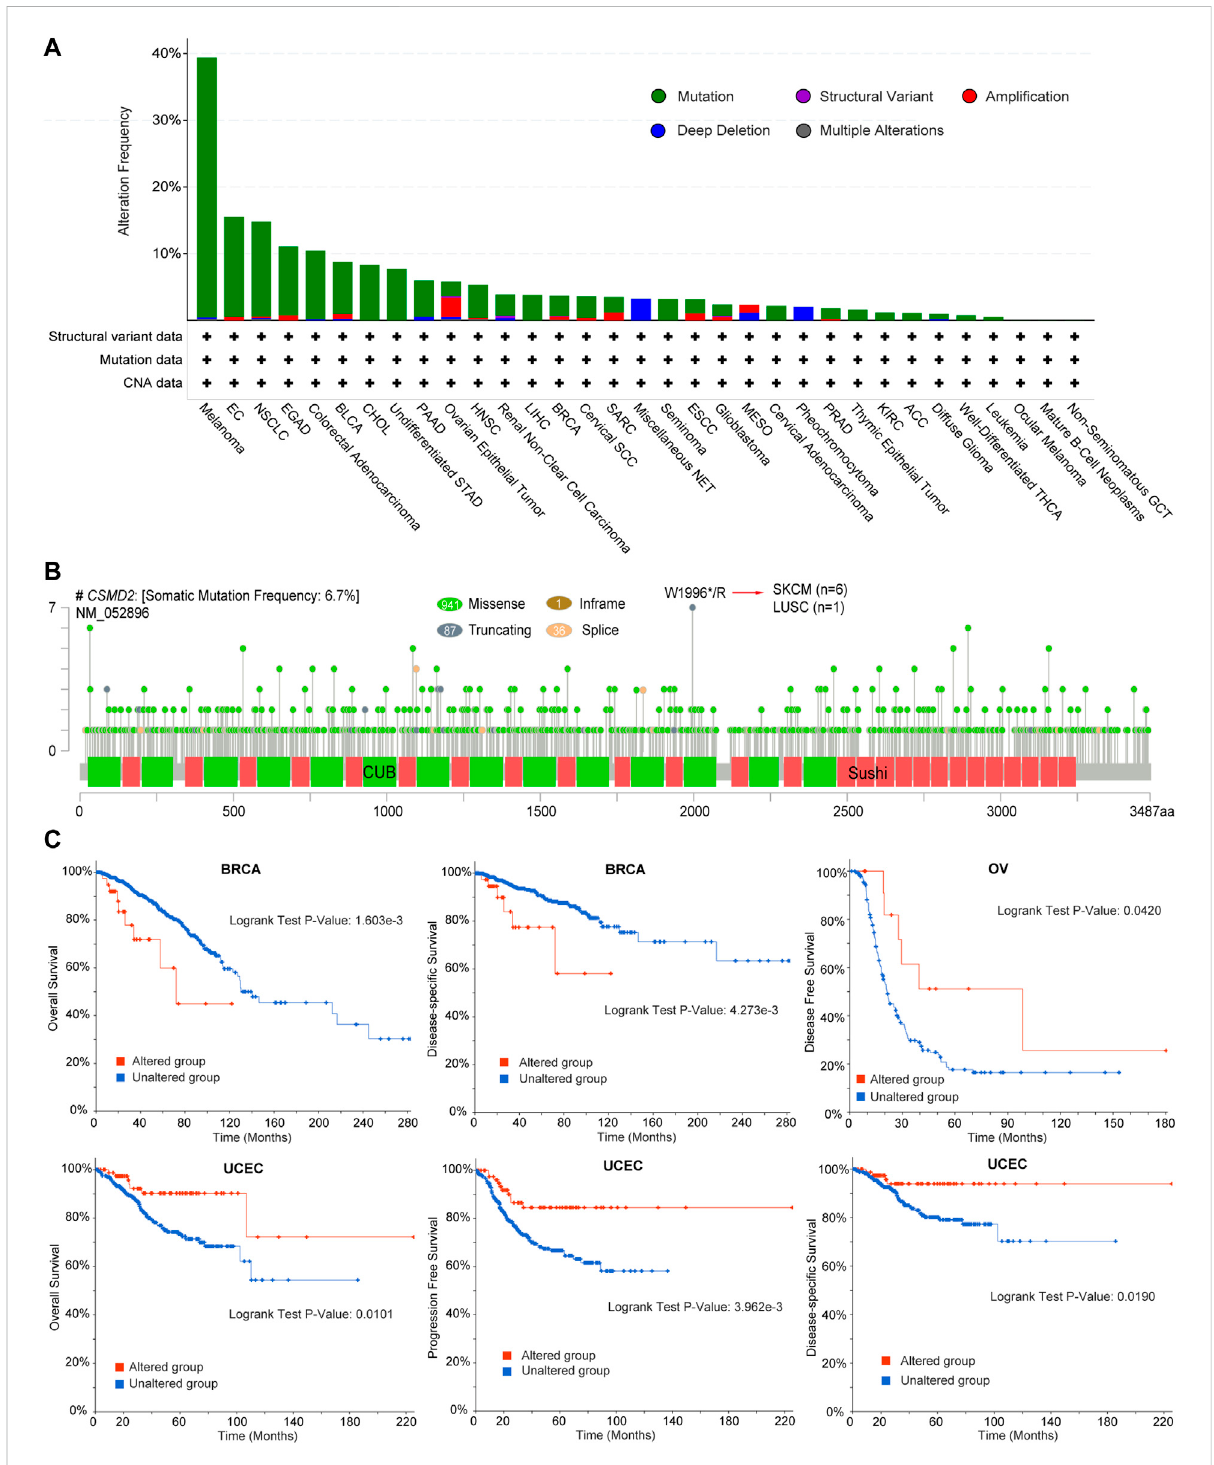
FIGURE 4 Genetic alteration characteristics of CSMD2. (A) Bar plot of CSMD2 alteration frequency and types across different cancer types (B) The landscape of CSMD2 mutation with the location, types, and number and their relationship with protein domains, and (C) Kaplan-Meier curves of differencesin OS, DSS,DFS, and PFSbetweenpatients with cancer with and withoutCSMD2 alteration based oncBioportal. Sushi: Sushi repeat (SCR repeat), CUB: CUB